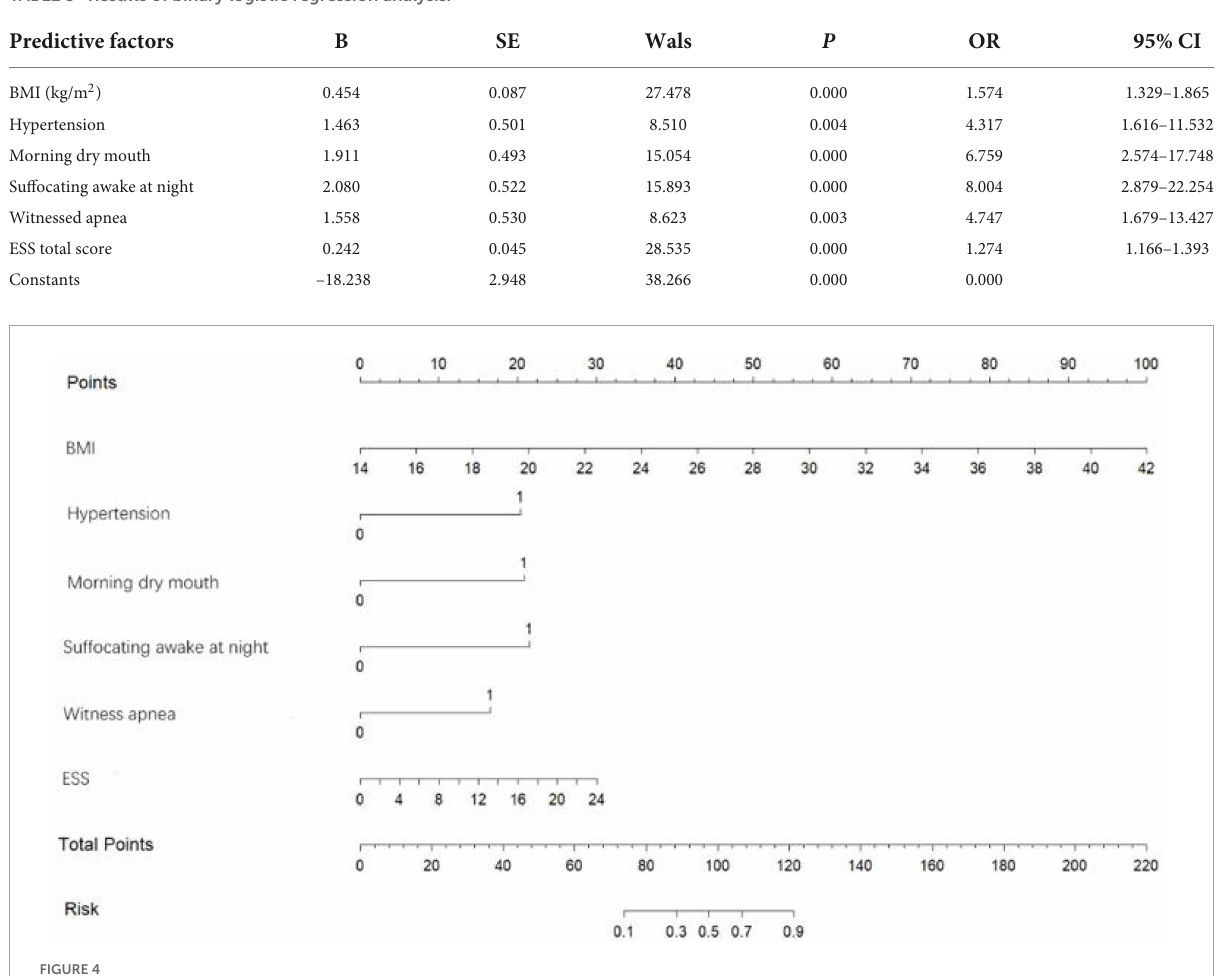
TABLE 3 Results of binary logistic regression analysis.